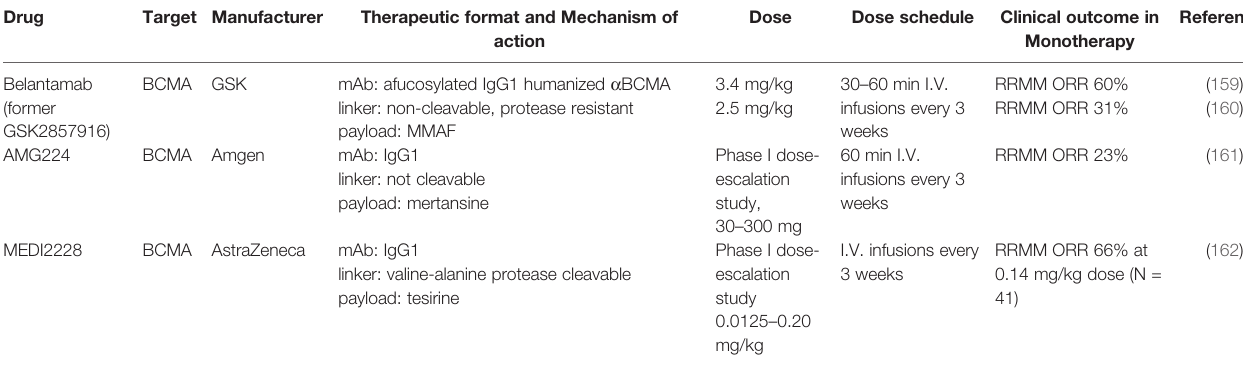
TABLE 4 | ADCs against BCMA in clinical development.